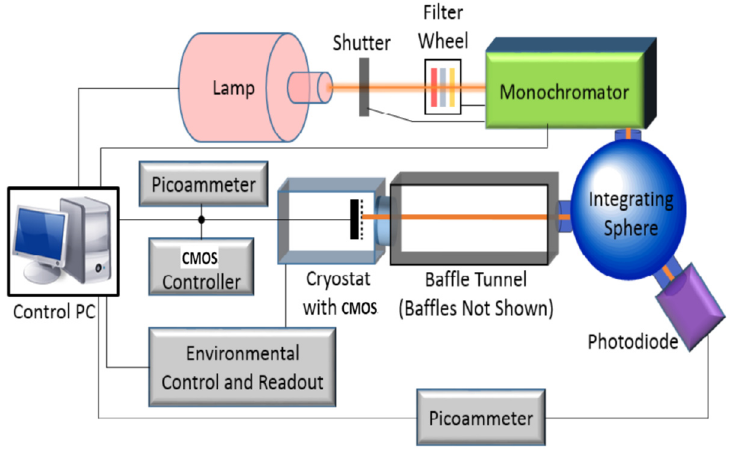
Figure 14. Schematic diagram of camera test system.